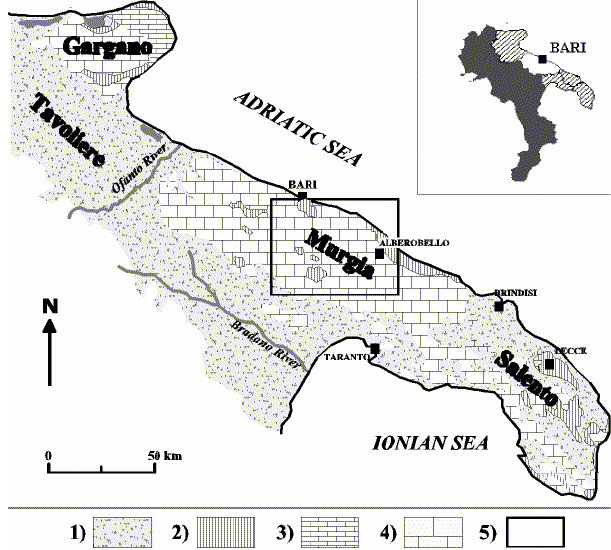
Figure 1 - Geological scheme of the Apulia Region. Upper rectangle: Southern Italy and 2 Fig. 1. Geological scheme of the Apulia Region. Upper rectangle: Southern Italy and provinces, white for Bari Province and lined for provinces, white for Bari Province and lined for the rest of the Apulian provinces. Main 3 the rest of the Apulian provinces. Main rectangle: (1) recent clastic rectangle: 1) Recent clastic cover (Pliocene–Pleistocene), 2) bioclastic carbonate rocks 4 cover (PliocenePleistocene), (2) bioclastic carbonate rocks (Paleo- (Paleogene) and calcarenites (Miocene), 3) chert-carbonate rocks (Upper Jurassic-5 gene) and calcarenites (Miocene), (3) chert-carbonate rocks (Upper Jurassic-Cretaceous), (4) carbonate platform rocks (Upper Jurassic- Cretaceous), 4) carbonate platform rocks (Upper Jurassic-Cretaceous), 5) study area. 6 Cretaceous), (5) study